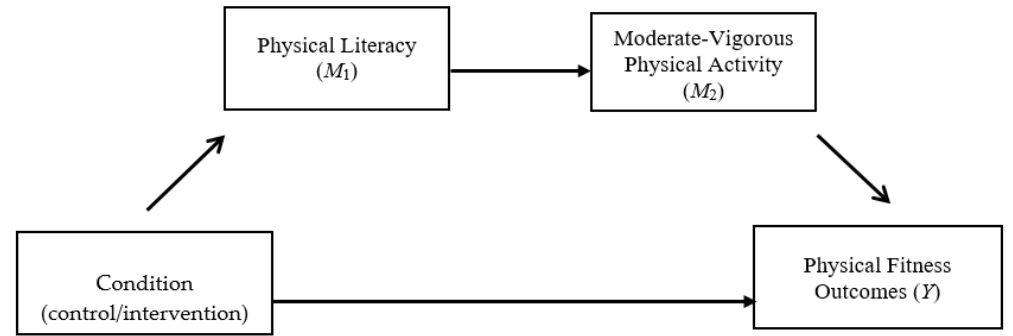
Figure 3. Condition—physical fitness sequential mediation model.